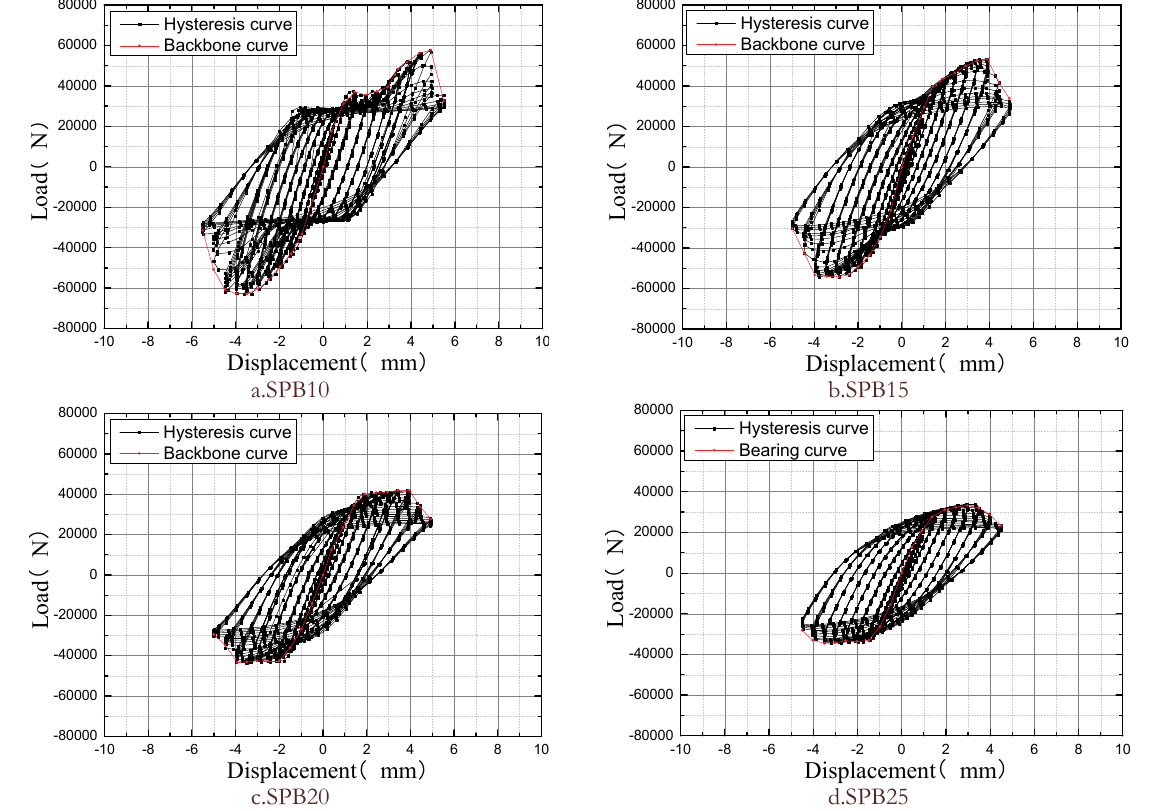
Figure 7: Hysteresis curves of dampers for SPB with different opening